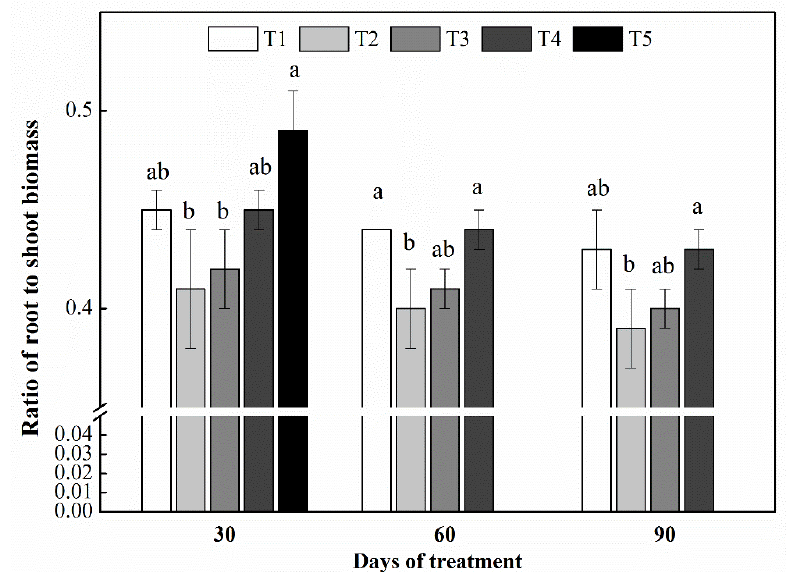
Figure 3. Ratios of root to shoot (including leaf and stem) biomass among the different treatments of nitrogen forms at various sampling times. Different letters indicate significant differences among different NO 3− /NH 4+ ratio treatments for the same sampling time according to Tukey’s test ( p < 0.05). All C. paliurus seedlings had died at 52 days after the treatment in T5.